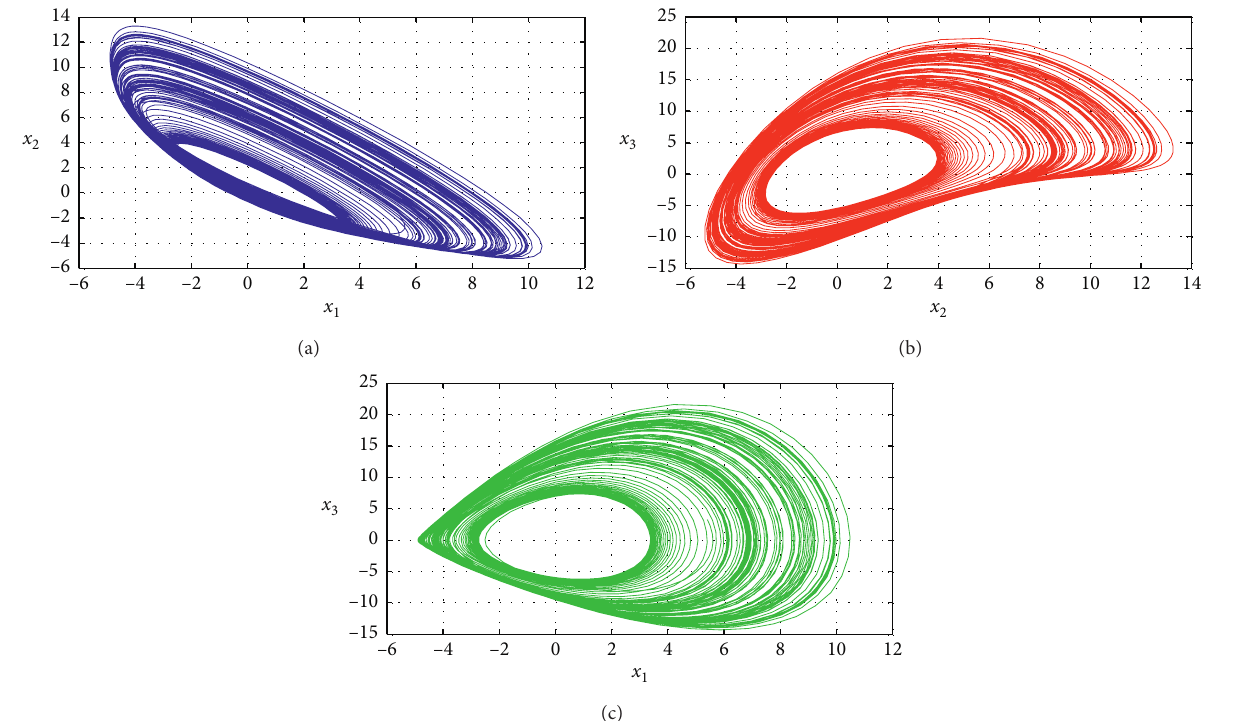
Figure 1: Projections of the strange attractor of system (1) with the initial condition ( 5 . 4 , − 1 . 8 , 3 . 3 ) : (a) x phase plane, and (c) x